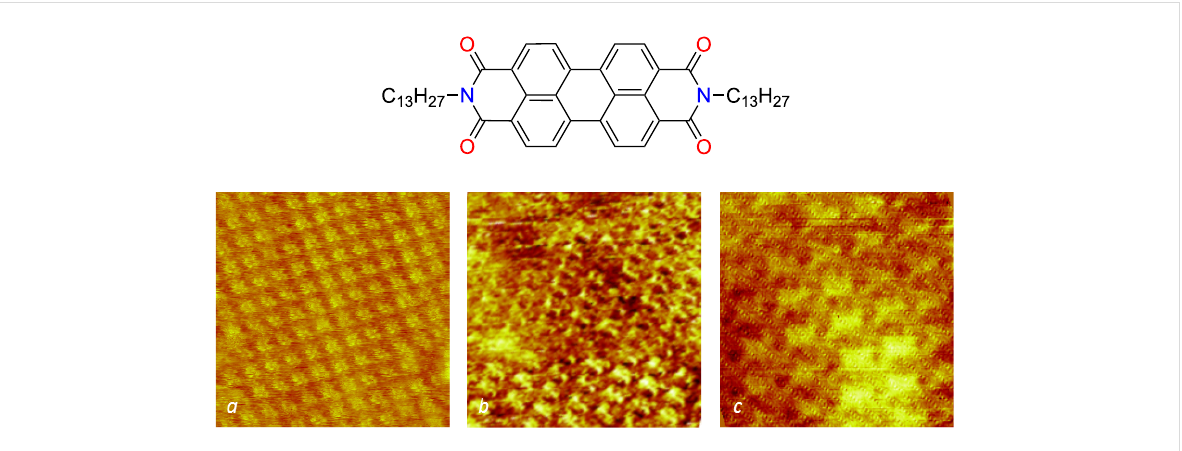
Figure 2: Structural characterization of the self-assembled PTCDI monolayers. Molecular formula of PTCDI-C13 and STM images of self-assembled monolayers on HOPG (a: 14 × 14 nm 2 ) as-grown CVD monolayer graphene on copper foil (b: 11 × 11 nm 2 ) and CVD graphene monolayer trans- ferred onto a PET plate (c: 8 × 8 nm 2 ). The typical current setpoint and sample bias were 10 pA and 800 mV, respectively. The images were acquired at the interface between the substrate and a ca. 10 − 5 M solution in phenyloctane at room temperature.